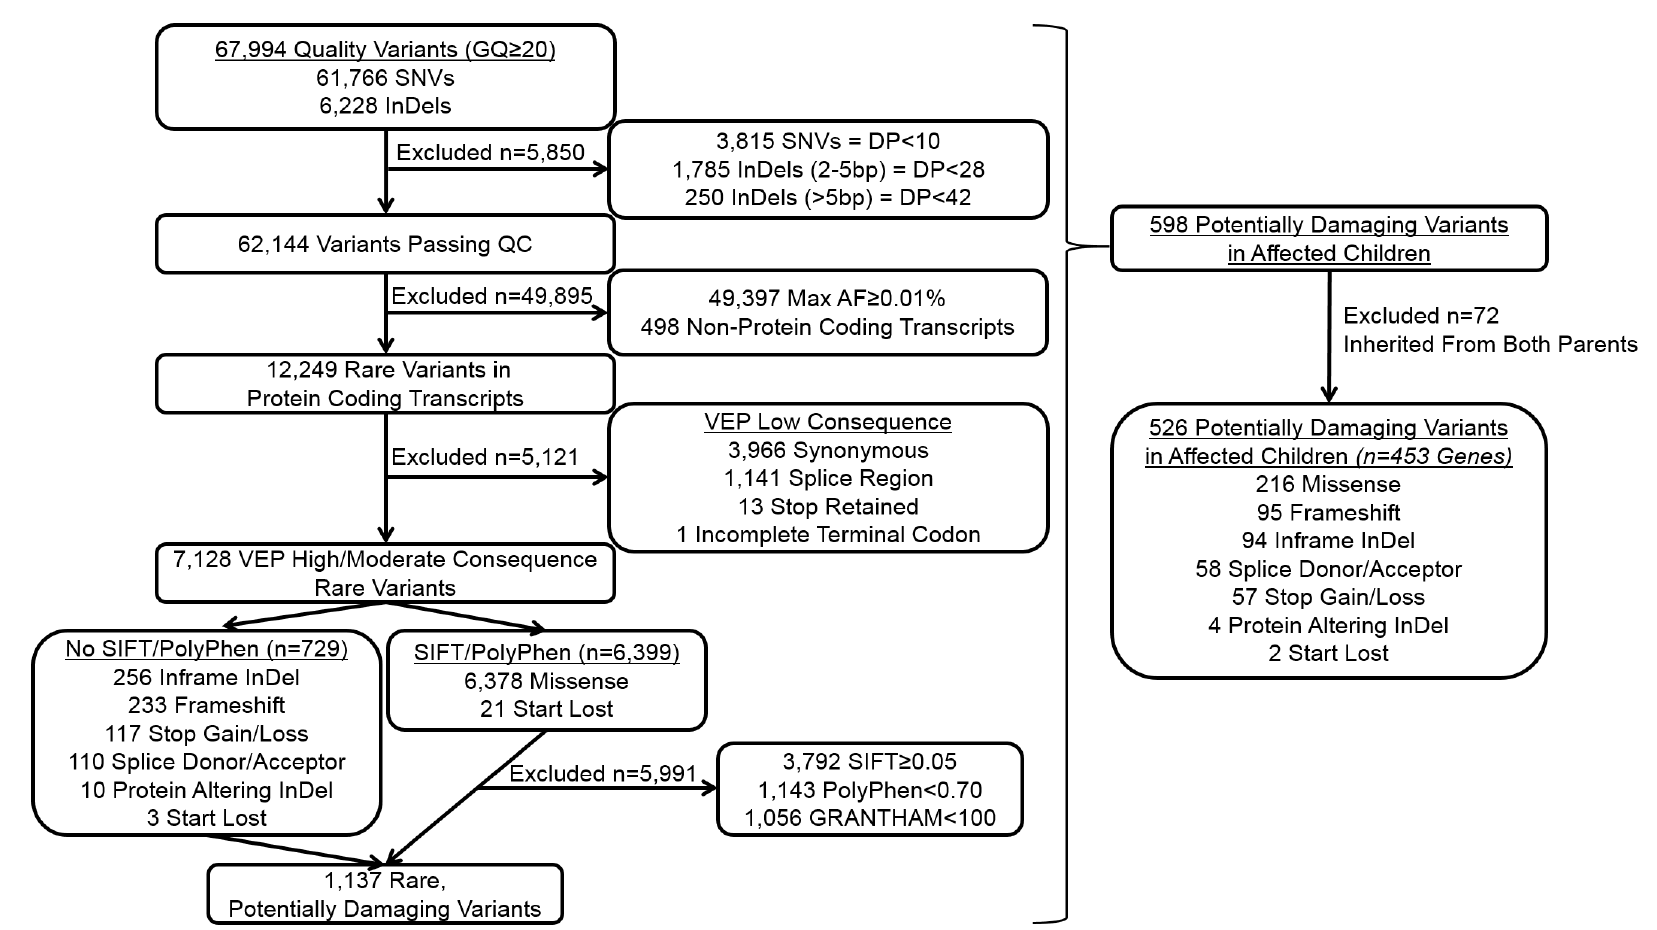
Figure 1. Quality control and variant selection. Overview of the criteria used to select high confidence, potentially damaging variants from whole-exome sequence data. Maximum allele frequencies (Max AF) were based on the maximum observed frequency across all reference populations available in the 1000 Genomes Project, the European Standard Population, and the Genome Aggregation Database. Abbreviations: GQ = genotype quality, SNVs=single nucleotide variant, InDels = insertion/deletion variant, DP = depth, VEP = Variant Effect Predictor.